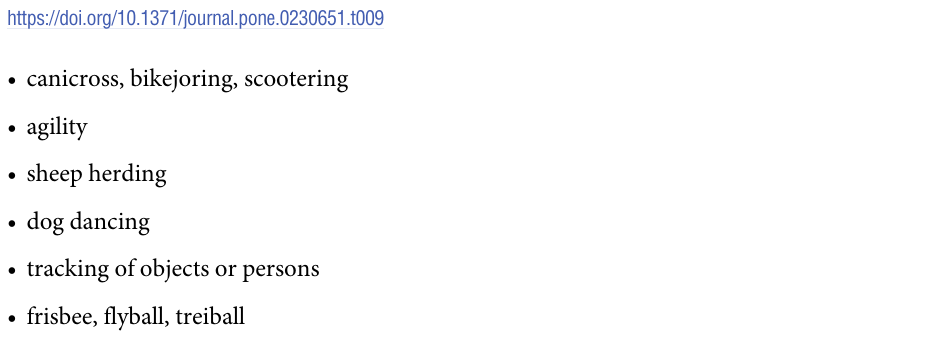
yes 16 15 Frequencies were assessed from the number of dogs for which behavioural troubles were reported by